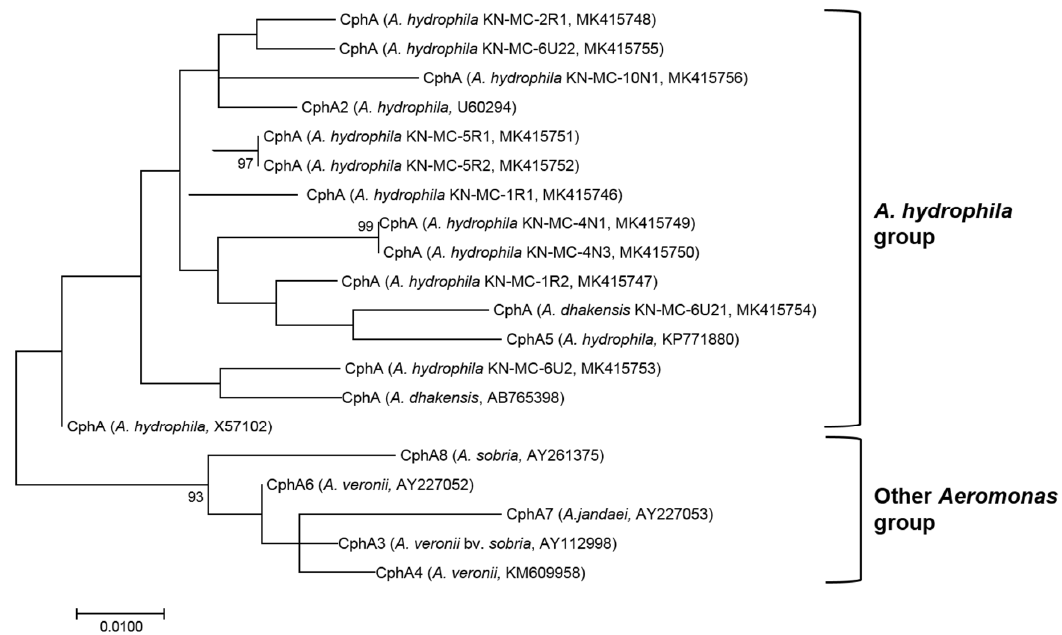
Figure 2. Maximum-likelihood phylogenetic tree based on cphA amino acid sequences showing the relationships of the deduced amino acid sequences of 11 cphA genes reported in this study to eight representative cphA variants in Aeromonadaceae. The scale bar represents 0.01 amino acid substitutions per site.